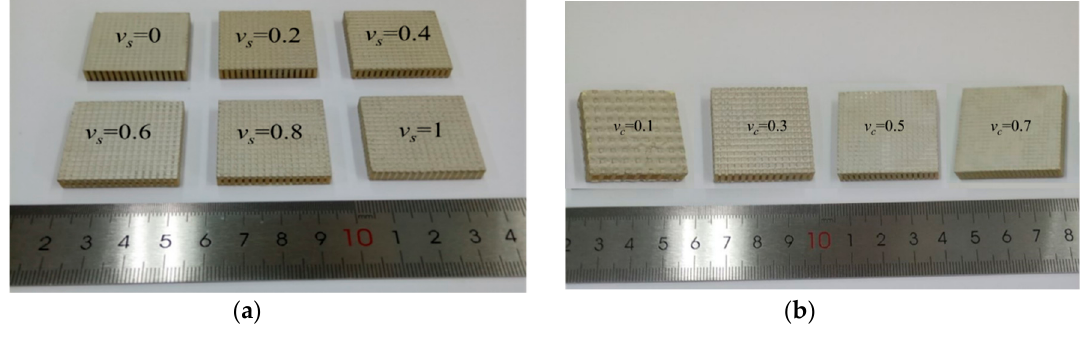
Figure 7. ( a , b ) Samples of the novel composite. Table 5. Experiment data with di ff erent v s (v c = 0.4).